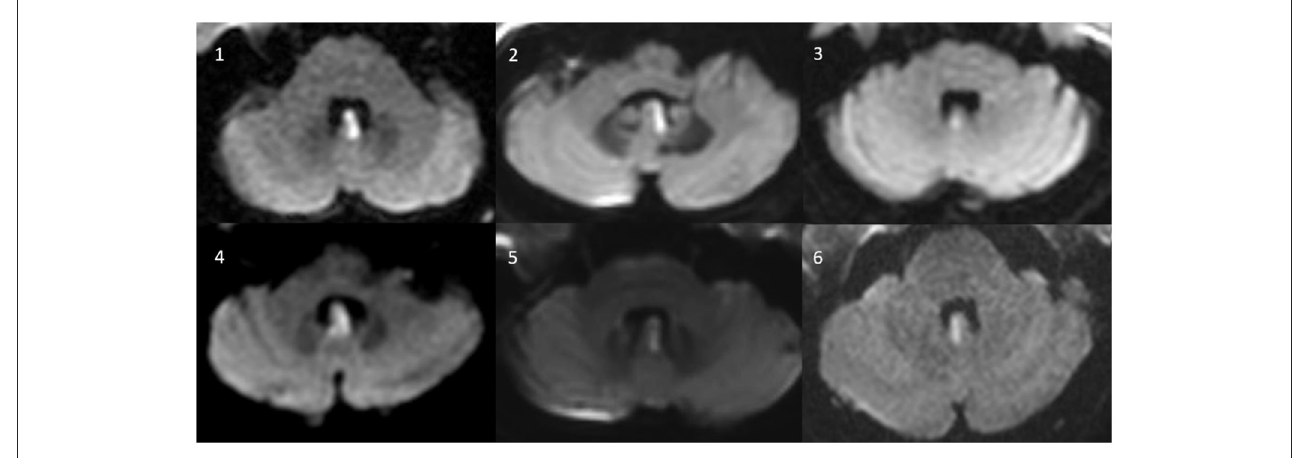
FIGURE1 Axial MR-images (diffusion weighted images) of all six patients with isolated (hemi)nodular